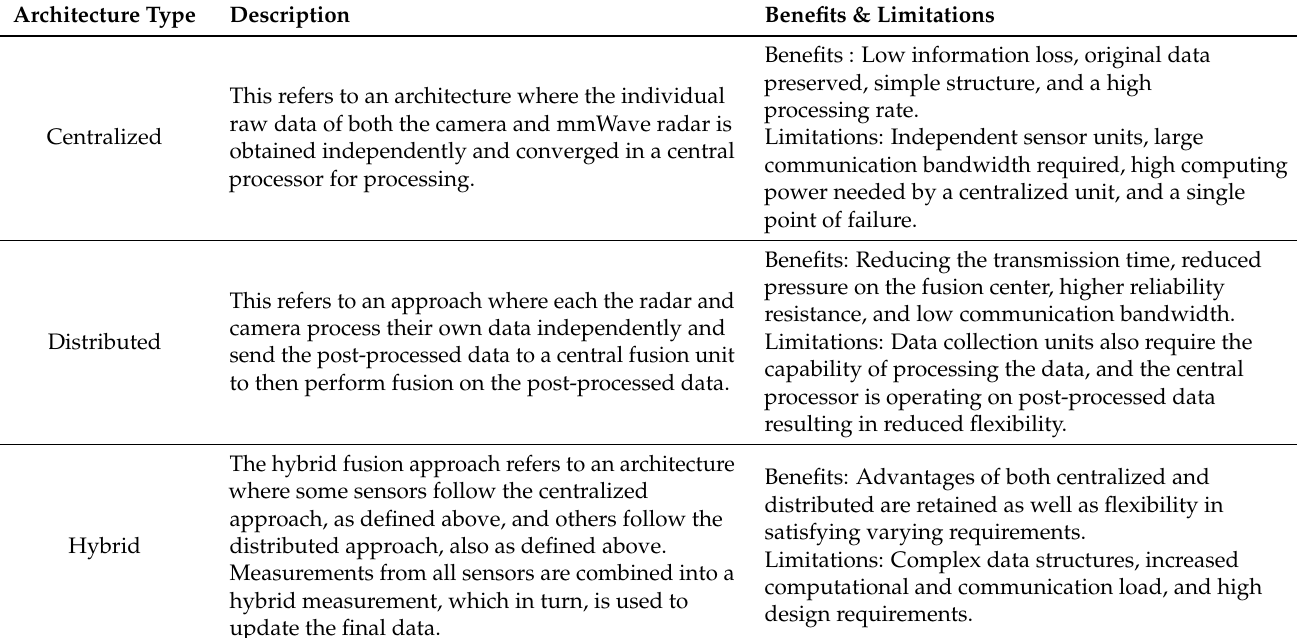
Table 1. Types of mmWave radar and camera fusion system